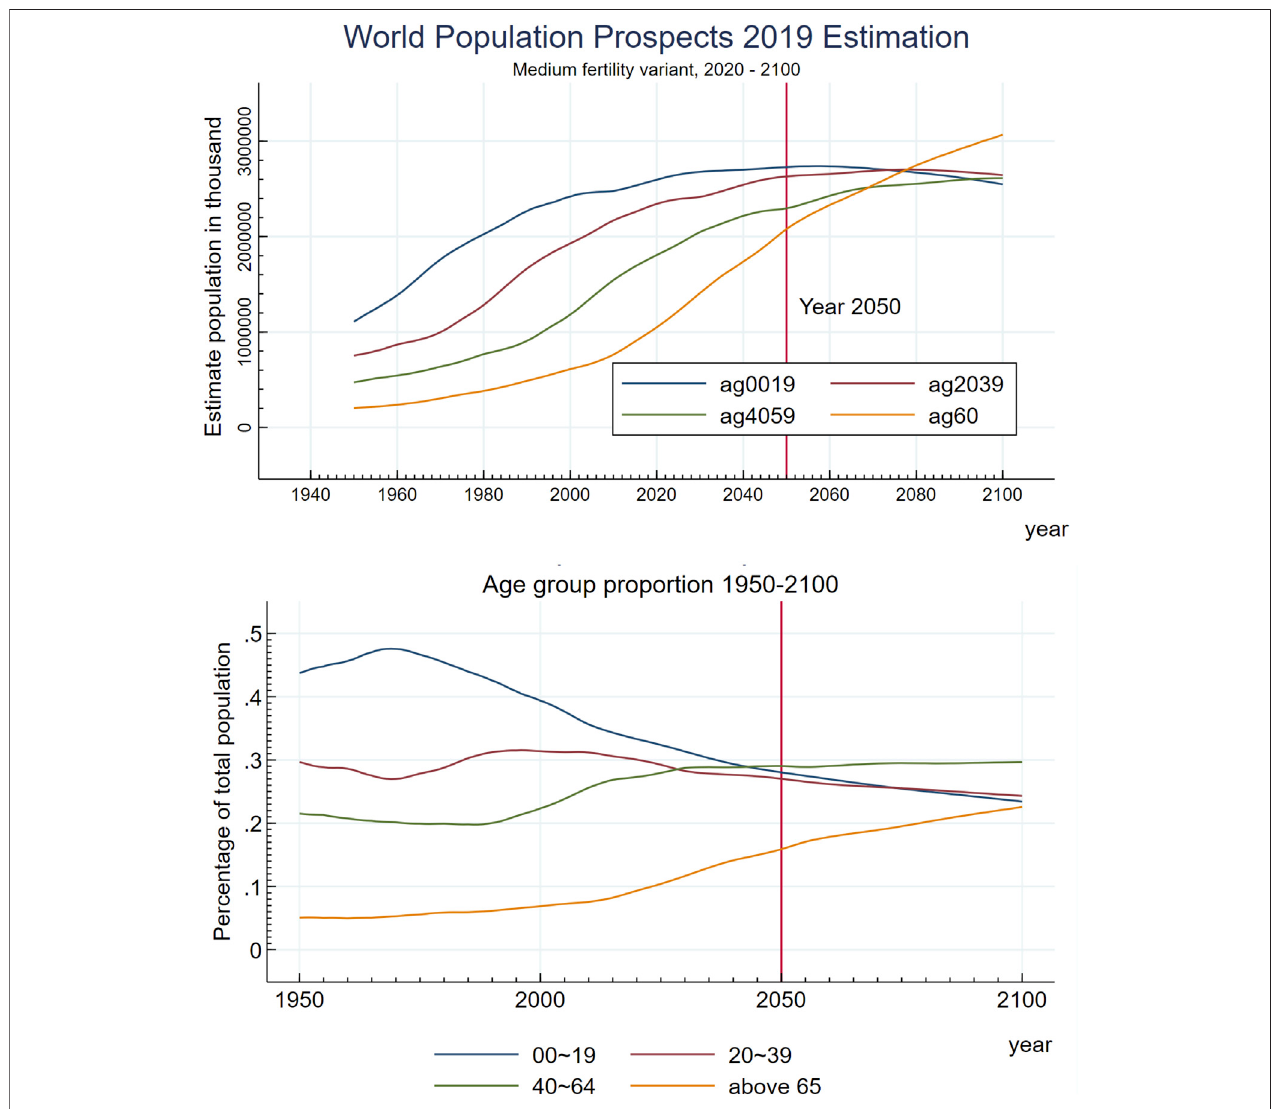
FIGURE 2 | The world population aging trend with estimation from WPP 2019. Here, red line stands for the year 2050.